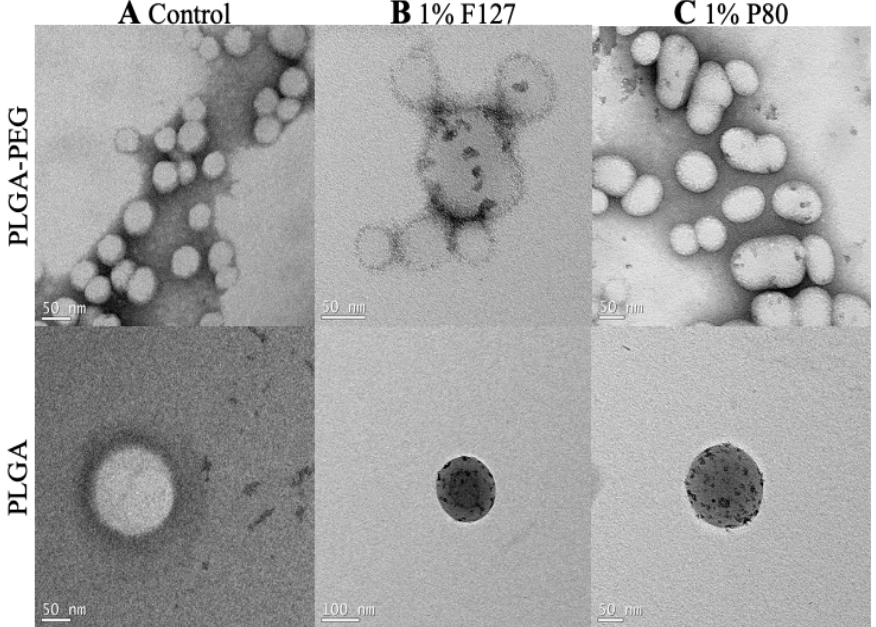
Figure 2. TEM images of PLGA-PEG and PLGA polymers with 1% F127 and 1% P80 surfactant solutions. ( A ) Controls are nanoparticles fabricated without surfactant solutions, ( B ) nanoparticles in 1% F127 solution, and ( C ) nanoparticles in 1% P80 solution. Scale bars: 50 nm and 100 nm.